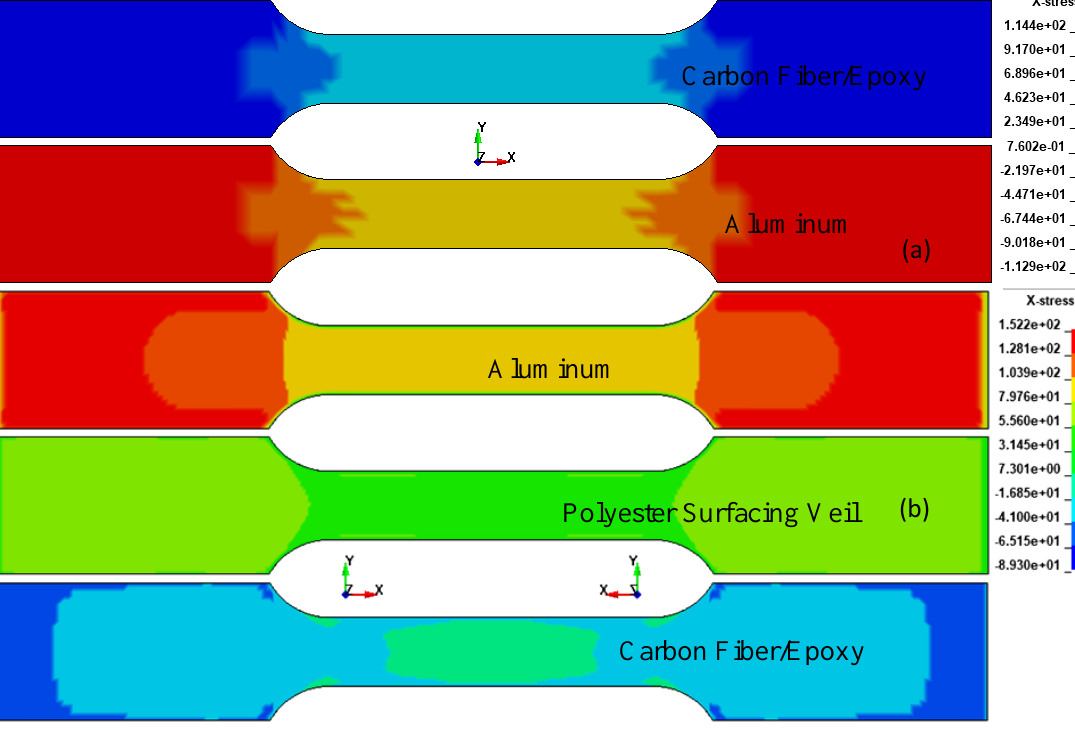
Figure 22. X stress plots for residual stresses; ( a ) CARALL-A, ( b ) CARALL-A with veil layers.